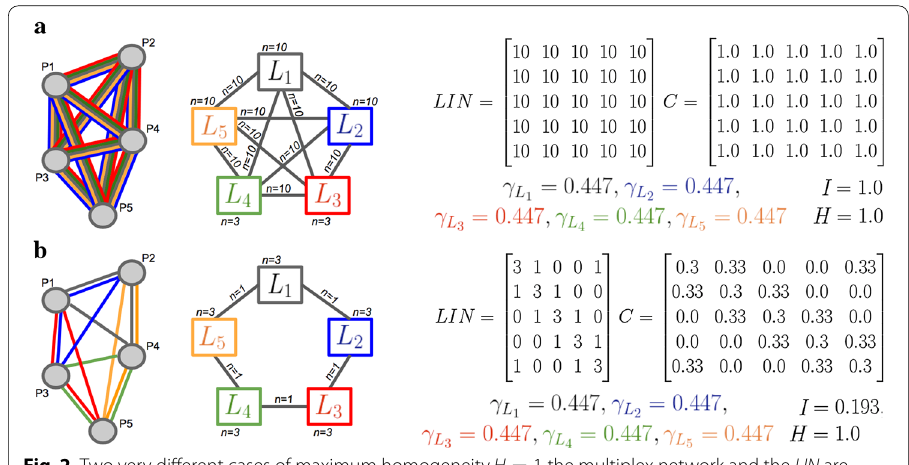
Fig. 2 Two very different cases of maximum homogeneity H = 1 , the multiplex network and the LIN are shown, with matrices and entanglement measures. a all layers are saturating all edges, so we have maximum intensity I = 1 ; b layers are well balanced, but we may have a lot more interactions